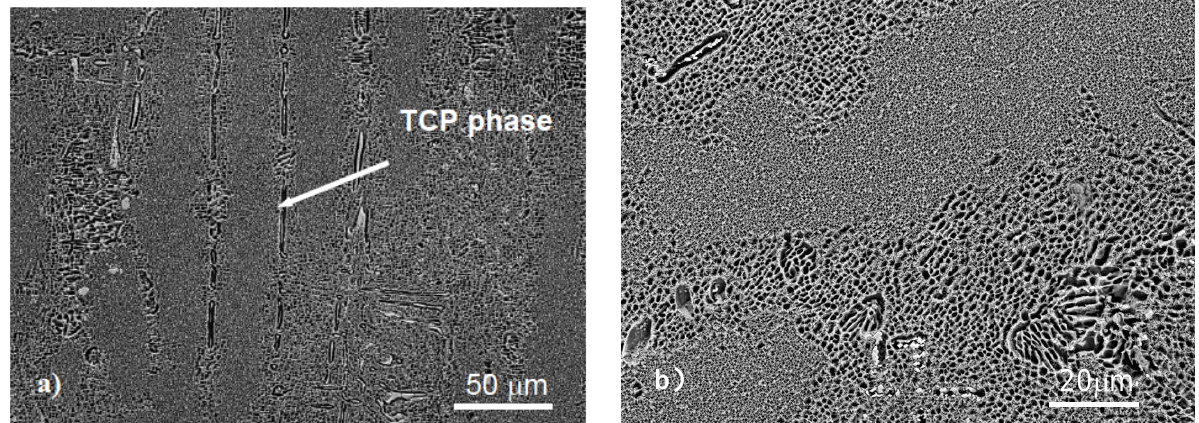
Figure 4: Microstructure of alloy G crept at 950 ∘ C and 400MPa at different